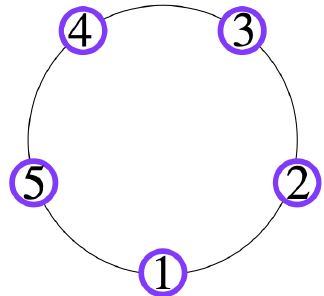
Figure 2: System with Periodic Boundary Conditions. If the state is translational invariant then the reduced density matrix on sites 1 and 2 or sites 3 and 4 or even sites 5 and 1 are all the